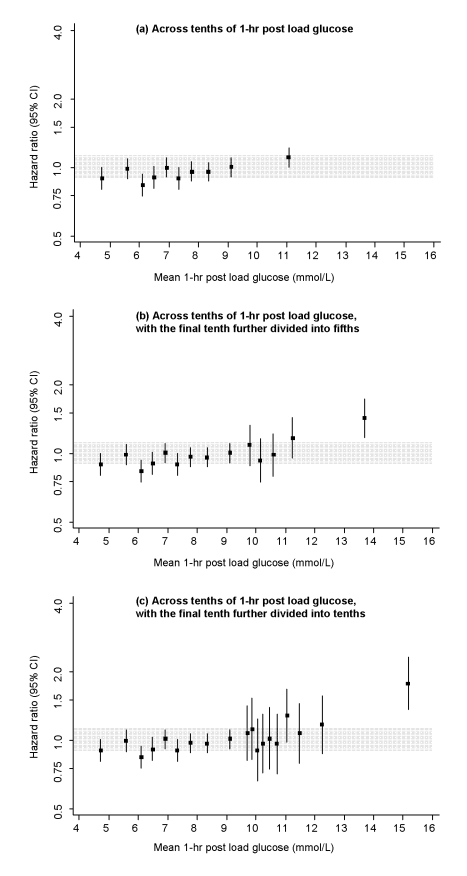
Risk of CHD across tenths of baseline 1 h post-load glucose levels in the Reykjavik Study.All hazard ratios are adjusted for age, sex, recruitment period, smoking status, systolic blood pressure, total cholesterol, and BMI, and all are compared to individuals in the middle tenth of the distribution. The grey area denotes the 95% CI of the reference group. Analyses involved the full range of glucose values (i.e., including individuals with glucose levels in the diabetic range). To limit any bias related to having a diagnosis of diabetes (e.g., medication use, lifestyle changes), however, individuals with a known history of diabetes at the baseline survey were excluded.